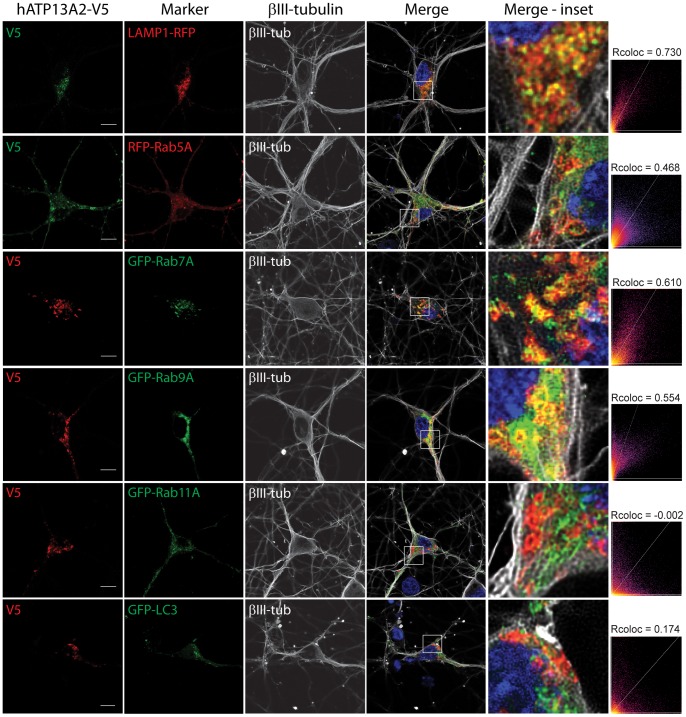
Co-localization of ATP13A2 with endosomal and lysosomal vesicular membranes in neurons.Confocal fluorescence microscopy reveals the co-localization of V5-tagged human ATP13A2 with lysosomal membranes (LAMP1-RFP), early (RFP-Rab5A) and late (GFP-Rab7A and GFP-Rab9A) endosomal compartments but fails to appreciably co-localize with recycling endosomes (GFP-Rab11A) or autophagosomes (GFP-LC3) within the soma of rat primary cortical neurons. Staining for the neuronal marker, βIII-tubulin, and nuclei (DAPI) are also indicated. Cytofluorograms and correlation coefficients (Rcoloc) indicate the extent of co-localization between ATP13A2 and vesicular markers. Confocal images are taken from a single z-plane at 0.15 µm thickness. Images are representative of at least two independent transfection experiments. Scale bar: 10 µm.